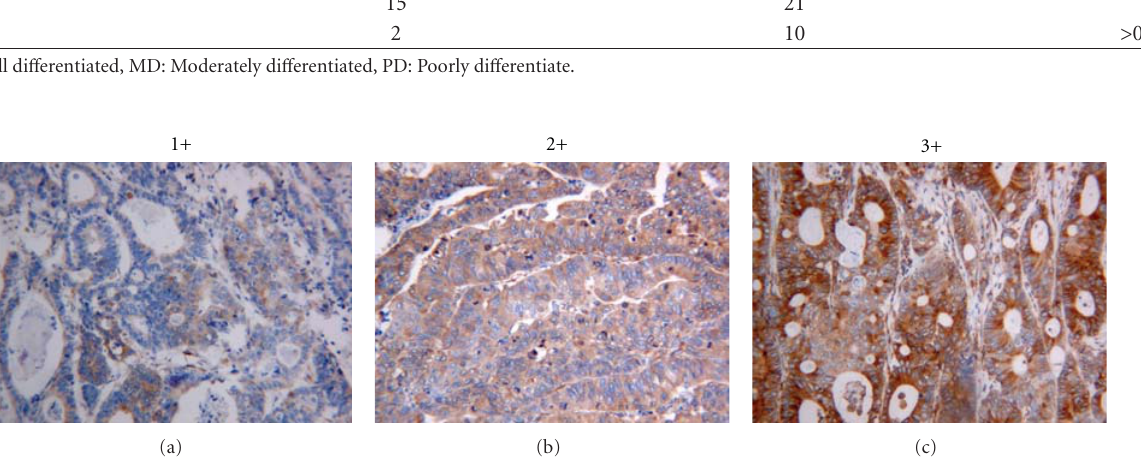
Figure 1: The expression of Cx43 in colonic adenocarcinoma was evaluated according to the intensity of the staining as follows: 1, very weak expression (1+); 2, moderate expression (2+); 3, strong expression (3+) (Original magnification × 200).